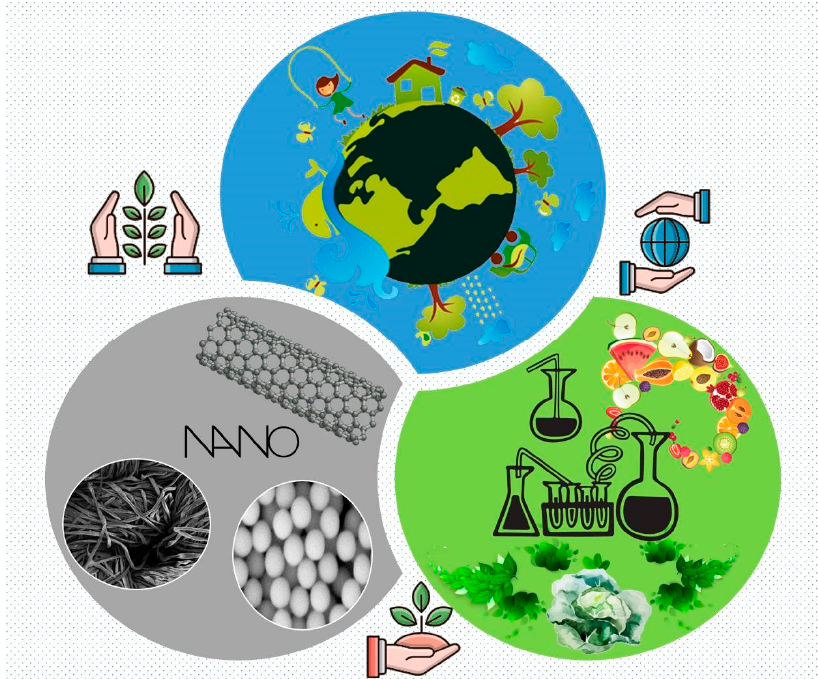
Figure 7. Nanotechnology can be a powerful development tool for society while considering sustainability as an important factor in this process and using more eco-friendly approaches during production.